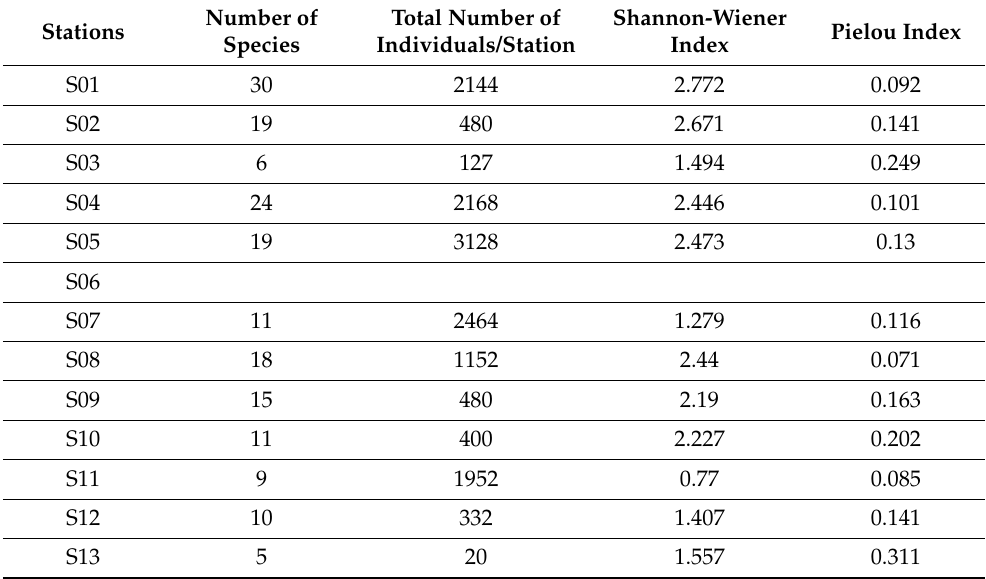
Table 4. Diversity and evenness of benthic wildlife at the thirteen sampling stations (1 to 13) of the road channel from the mouth of the Casamance estuary to Ziguinchor.